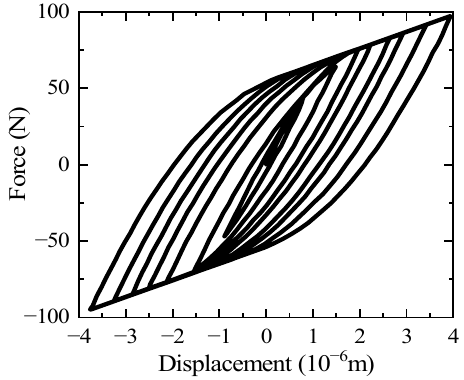
Figure 2. Typical hysteresis loops of the adjusted Iwan model.